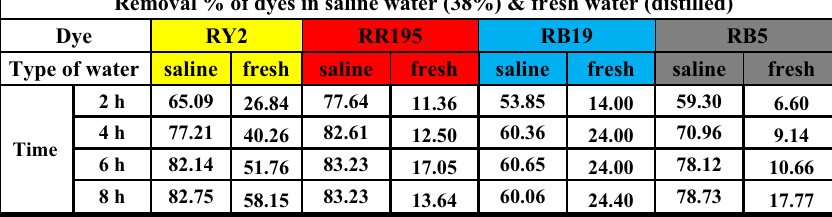
Table 9 Removal percentages of the four studied dyes by fresh Ulva fasciata under saline and fresh